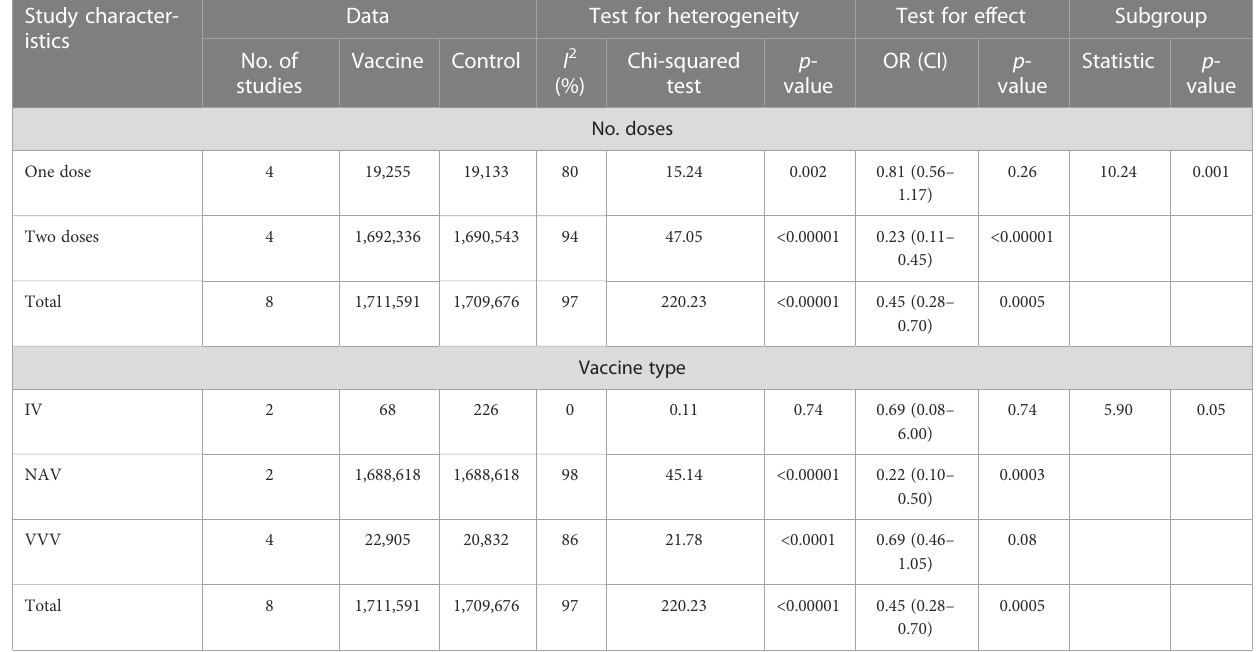
95% CI = 0.46 – 1.05, p = 0.08).